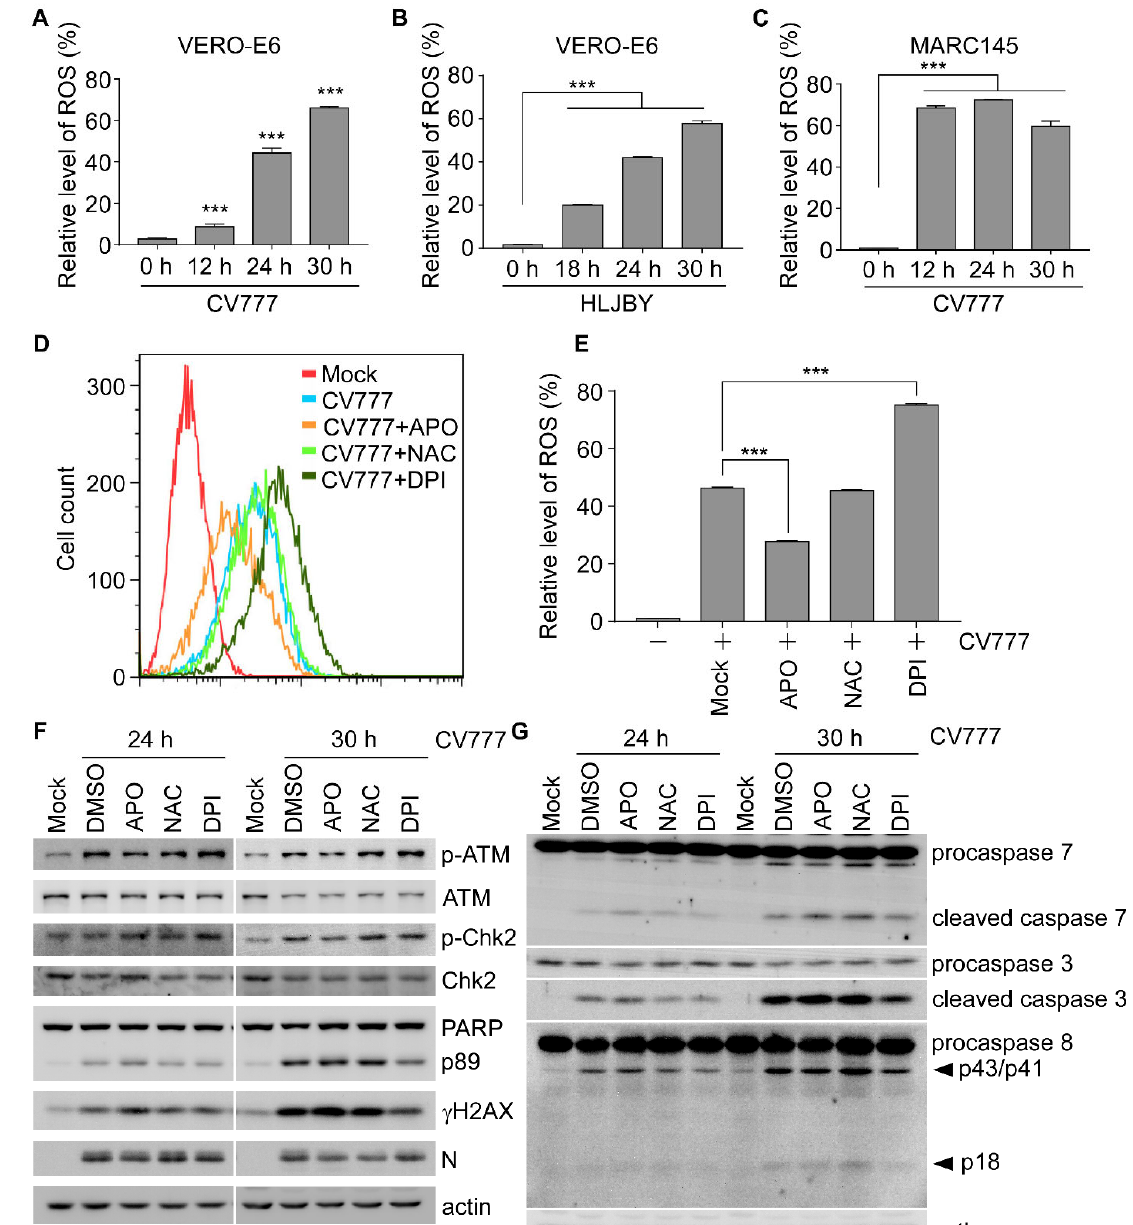
Figure 3. PEDV ‐ induced cellular ROS contributes to the activation of the ATM signaling. ( A ) ROS levels were measured with Vero ‐ E6 cells uninfected or infected with CV777 (1 MOI) for 12, 24, and 30 h. The relative ROS levels were calculated by the DCF fluorescence intensity in PEDV ‐ infected cells. Results are representative of three independent experiments. ( B ) ROS levels were measured with Vero ‐ E6 cells uninfected or infected with HLJBY (1 MOI) at 18, 24, and 30 h. ( C ) The experiment was performed as in A, except using Marc145 cells. ( D ) ROS levels were measured in Vero ‐ E6 cells pre ‐ treated with DMSO, APO (1 mM), NAC (100 μ M), or DPI (0.5 μ M) for 2 h and followed by CV777 (1 MOI) infection in the presence of DMSO, APO (1 mM), NAC (100 μ M), or DPI (0.5 μ M) for 24 h. ( E ) The quantification of the relative ROS levels calculated by the DCF fluorescence intensity in cells that were treated as in D. Results are representative of three independent experiments. ( F , G ) Western blots were prepared with extracts from Vero ‐ E6 cells treated with DMSO, APO (1 mM), NAC (100 μ M), or DPI (0.5 μ M) for 2 h before and during infection with CV777 (1 MOI) for 24 and 30 h (* p < 0.05; ** p < 0.01; *** p < 0.001).